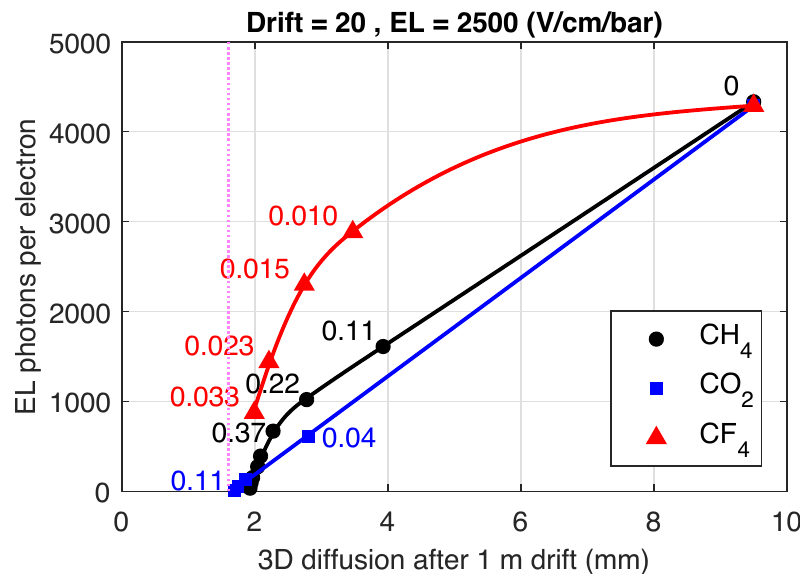
Figure 7 . Number of xenon EL photons per primary electron, extrapolated to the NEXT-100 TPC operating conditions ( E=p = 20 V/cm/bar in the drift region and E=p = 2 : 5 kV/cm/bar in the EL region, p = 10 bar), as a function of the simulated 3D di(cid:11)usion after 1 meter of drift for di(cid:11)erent concentrations (indicated in %) of the molecular additives investigated in this work (CO 2 , CH 4 and CF 4 ). The vertical line indicates the thermal di(cid:11)usion for the described